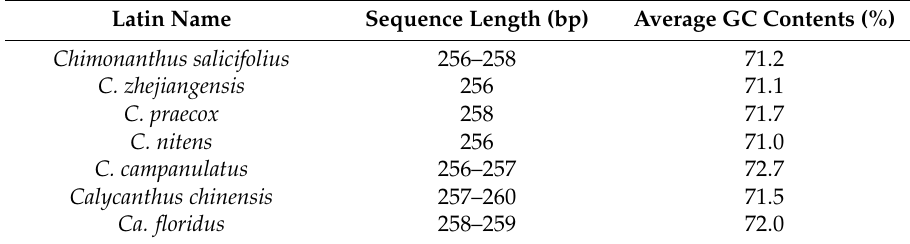
Table 2. Sequence length and average GC contents of Shi-Liang tea and its closely related species.